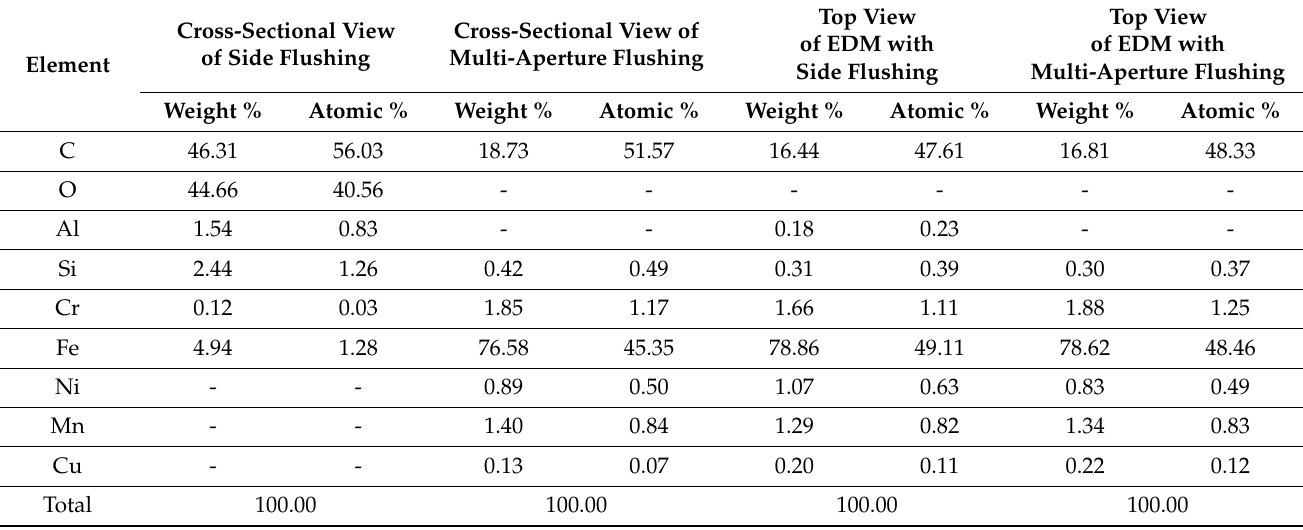
Table 14. EDS analysis of cross-sectional view and top view of deep hole surface of EDM with side and multi-aperture flushing at 30 mm machining